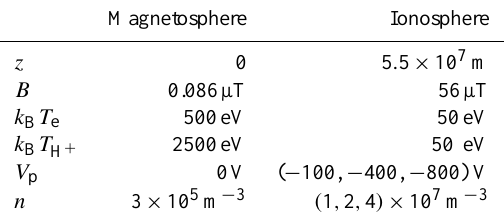
Table 1. Parameters used in the simulations at the magnetospheric and ionospheric boundaries. The multiple values given for V p and n at the ionosphere correspond to different simulation runs.